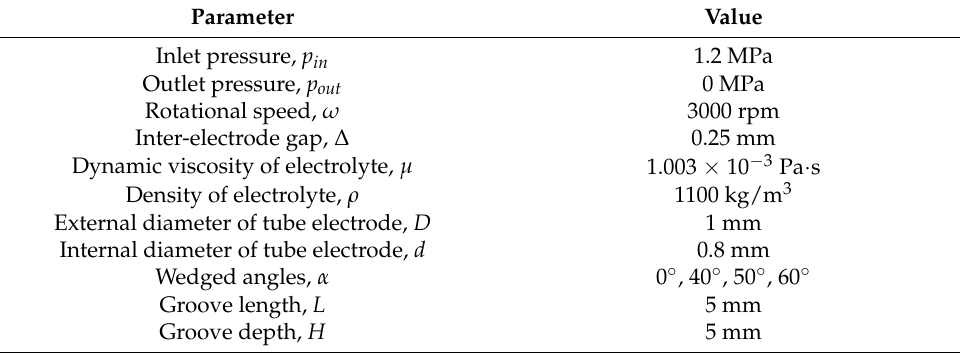
Table 1. The parameters for the simulation.